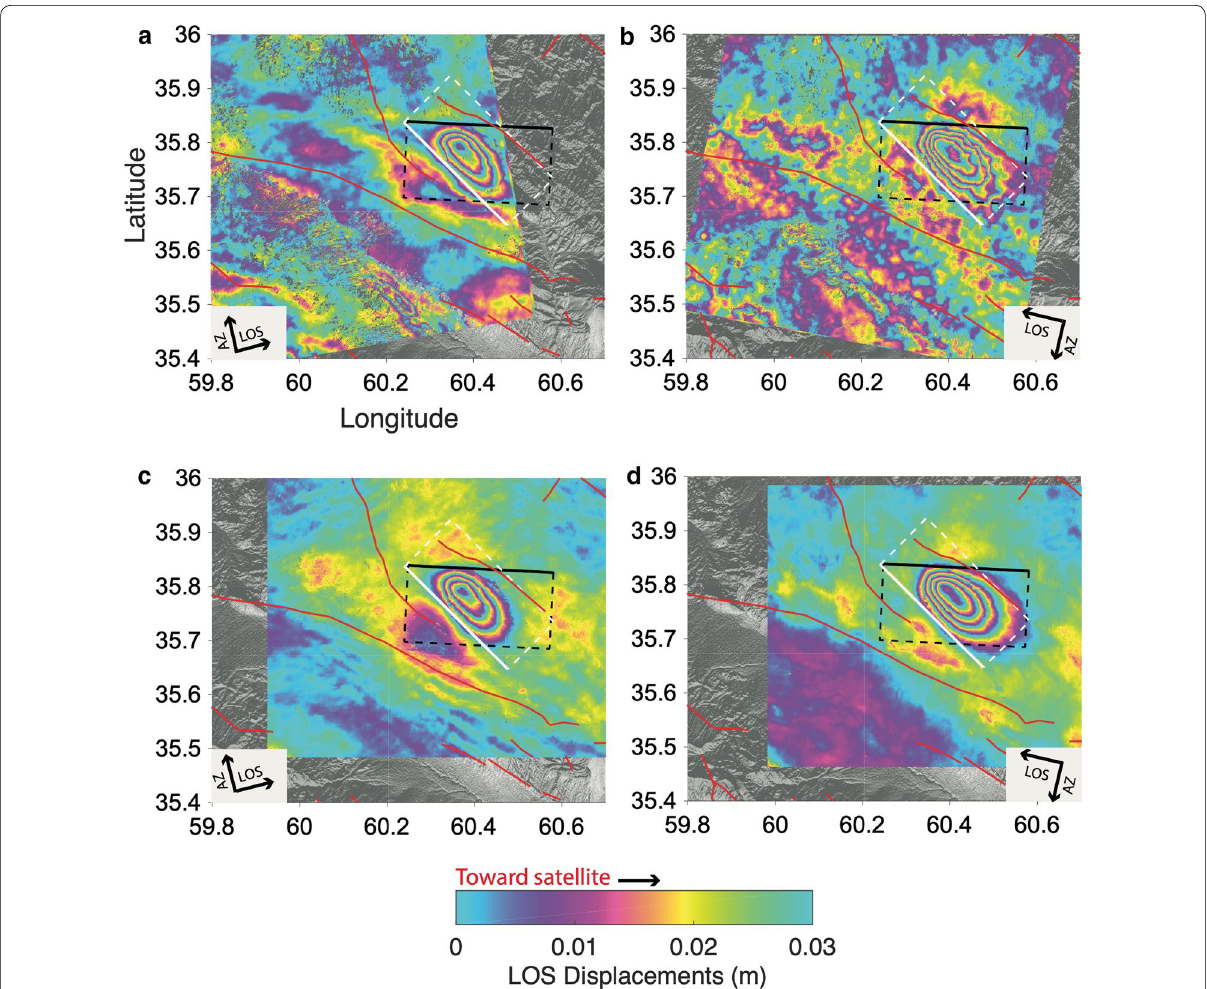
Fig. 2 SAR interferograms without atmospheric corrections showing line-of-sight (LOS) displacements caused by the 2017 Sefid Sang earthquake, rewrapped with an interval of 3 cm. a , b ALOS-2 interferograms from ascending track 171 and descending track 64, respectively. c , d Sentinel-1A interferograms from ascending track 13 and descending track 93, respectively. The white and black rectangles represent the northeast- and south-dipping fault models, respectively, determined by the inversions in this study. The black arrows represent satellite heading (azimuth) and LOS